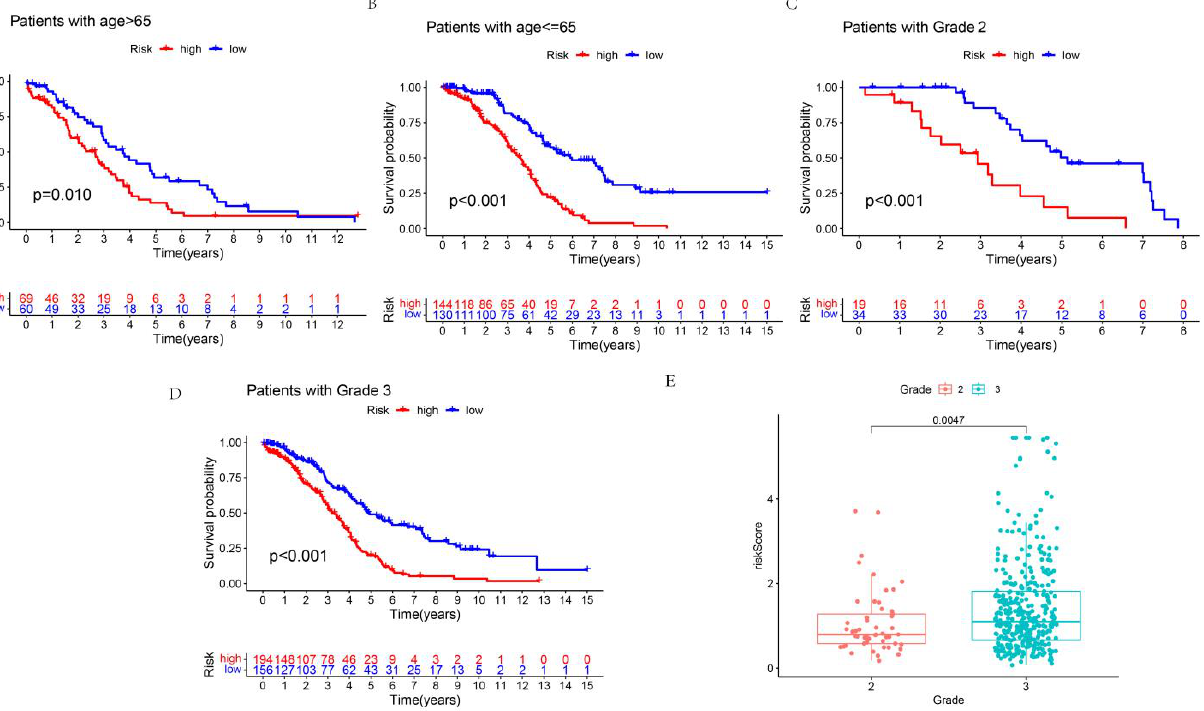
Figure 4. Correlations between protein risk score and clinical indicators. ( A ) Kaplan–Meier survival curve for overall survival (OS) in patients age >65 years. ( B ) Kaplan–Meier survival curve for OS in patients age ≤65 years. ( C ) Kaplan–Meier survival curve for OS in patients with Grade 2. ( D ) Kaplan–Meier survival curve for OS in Grade 3 patients. ( E ) Scatter plot showing the correlation between risk score and grade in OS.